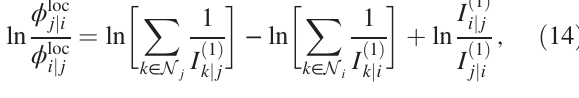
Table I]. To derive Eq. (2), we multiply Eq. (14) by the thermal energy and